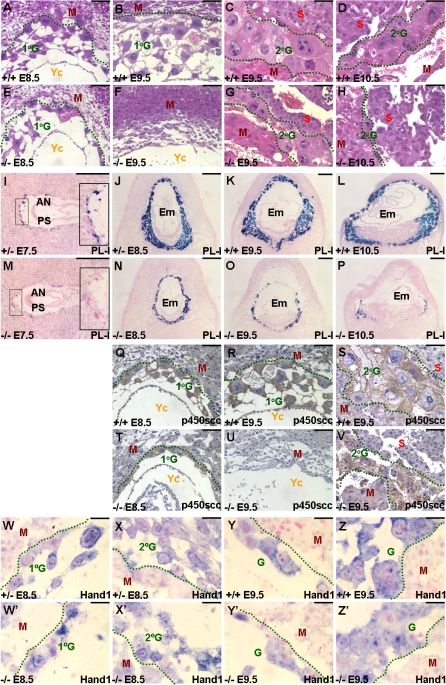
Development of TGCs is Impaired in the SENP2 Mutants(A–H) Histological analysis of the SENP2+/+ (A–D) and SENP2–/– (E–H) placentas revealed impaired development of both primary (1°G; A,B,E,F) and secondary (2°G; C,D,G,H) caused by SENP2 ablation at E8.5 (A,E), E9.5 (B,C,F,G) and E10.5 (D,H).(I–P,W–Z′) TGC development was examined by in situ hybridization analysis of specific markers PL-I (I–P) and Hand1 (W–Z and W′–Z′) at the stages shown (E7.5–E10.5). Stained (blue) sections were counterstained with nuclear fast red. In (I, M), enlargements of the left insets are shown on the right insets.(Q–V) Immunostaining of p450scc characterized the TGC in SENP2+/+ (Q–S) and SENP2–/– (T–V) at E8.5 (Q,T), and E9.5 (R,S,U,V). Immunostained (brown) sections were counterstained (blue) with hematoxylin.The TGC layers are defined by broken green lines (A–E,G,H,Q–Z,W′–Z′). AN, anterior neural fold; Em, embryo; G, TGC layer; M, maternal decidua; PS, primitive streak; S, spongiotrophoblast layer; Yc, yolk sac cavity. Scale bars, 500 μm (I–P); 100 μm (A,B,E,F,Q,R,T,U); 50 μm (C,D,G,H,S,V,W–Z,W′–Z′).